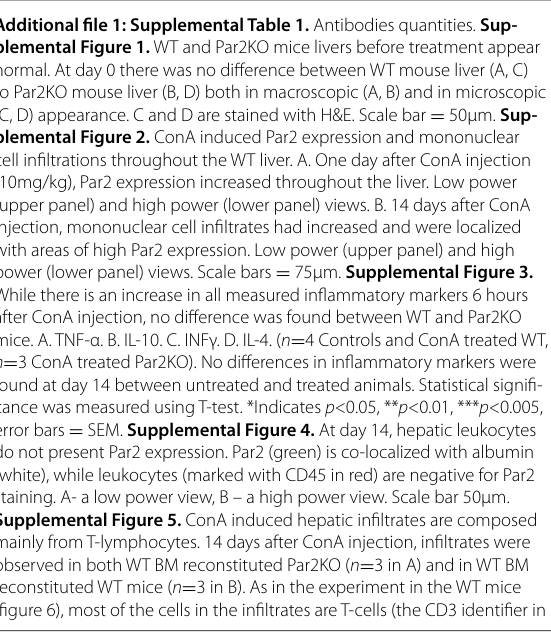
Additional file 1: Supplemental Table 1. Antibodies quantities. Sup‑ plemental Figure 1. WT and Par2KO mice livers before treatment appear normal. At day 0 there was no difference between WT mouse liver (A, C) to Par2KO mouse liver (B, D) both in macroscopic (A, B) and in microscopic